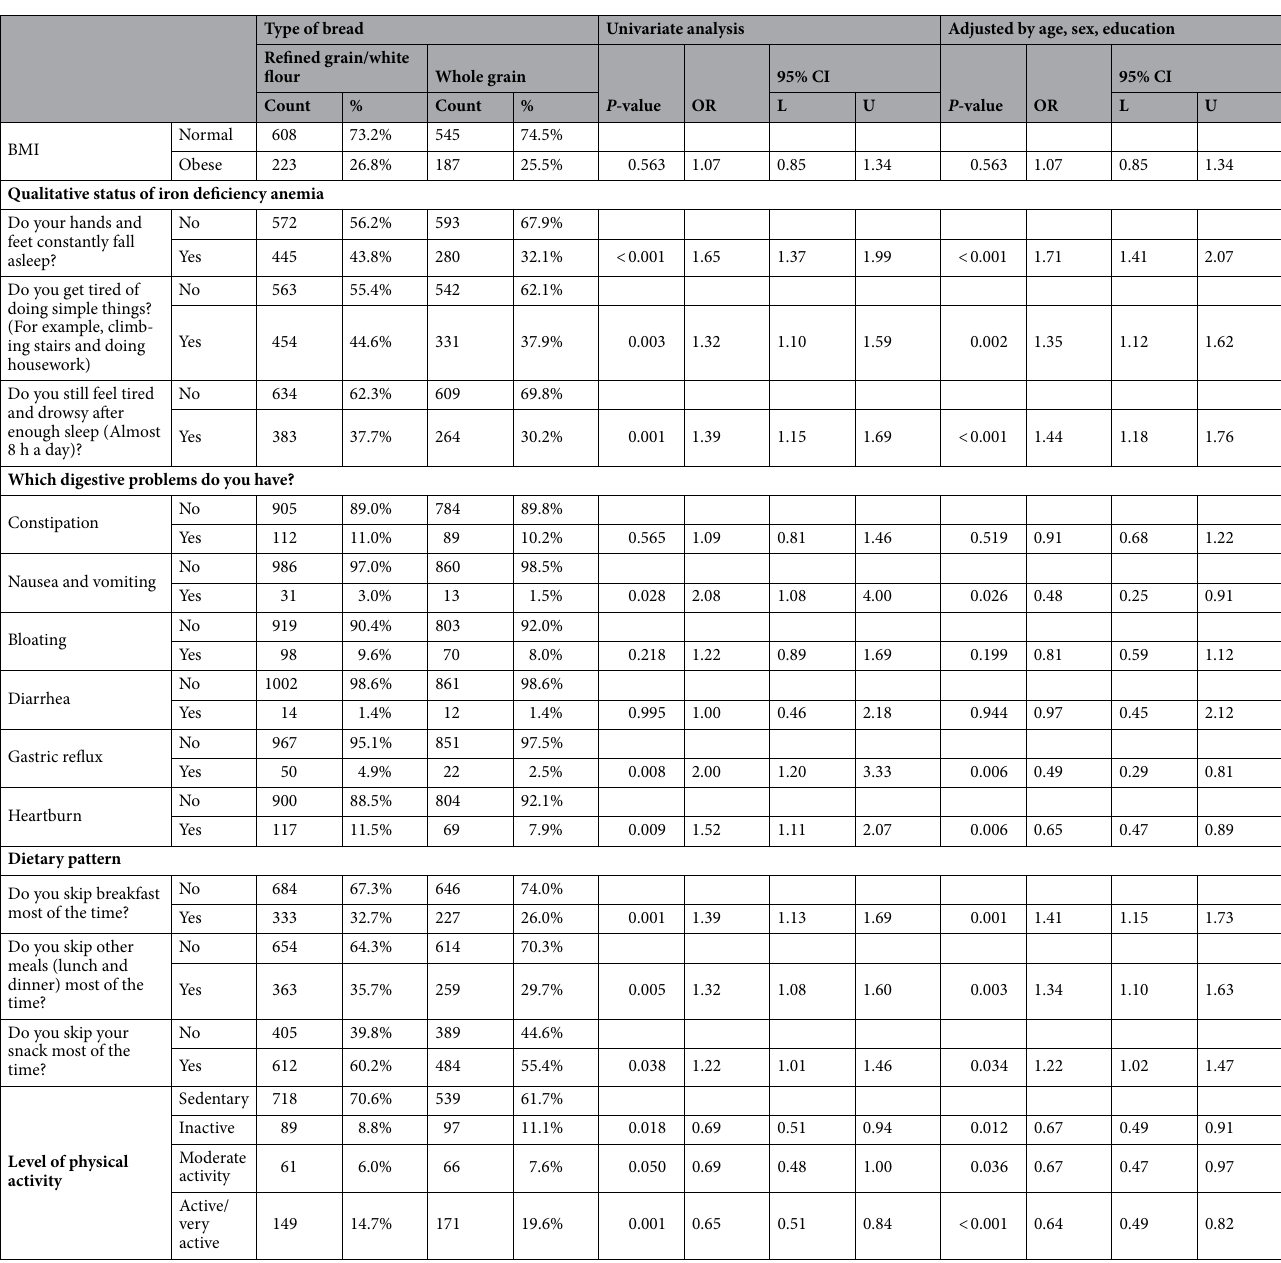
Table 4. The relationship between the qualitative status of iron deficiency anemia, digestive problems, dietary pattern, and level of physical activity with the type of bread in the students. BMI, Body mass